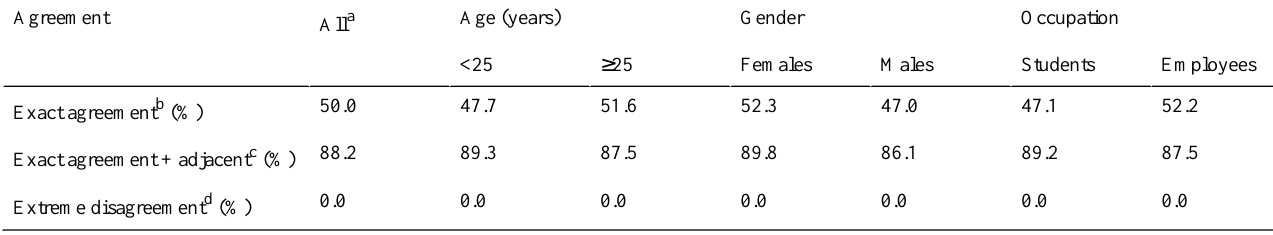
Table 10. Cross-classification analysis derived from the electronic 12-hour dietary recall app versus the 4 dietary records for categories of food group consumption and strata: age (years): <25 and ≥ 25; gender: females and males; and occupation: students and employees. Comparison of the electronic 12-hour dietary recall app versus dietary